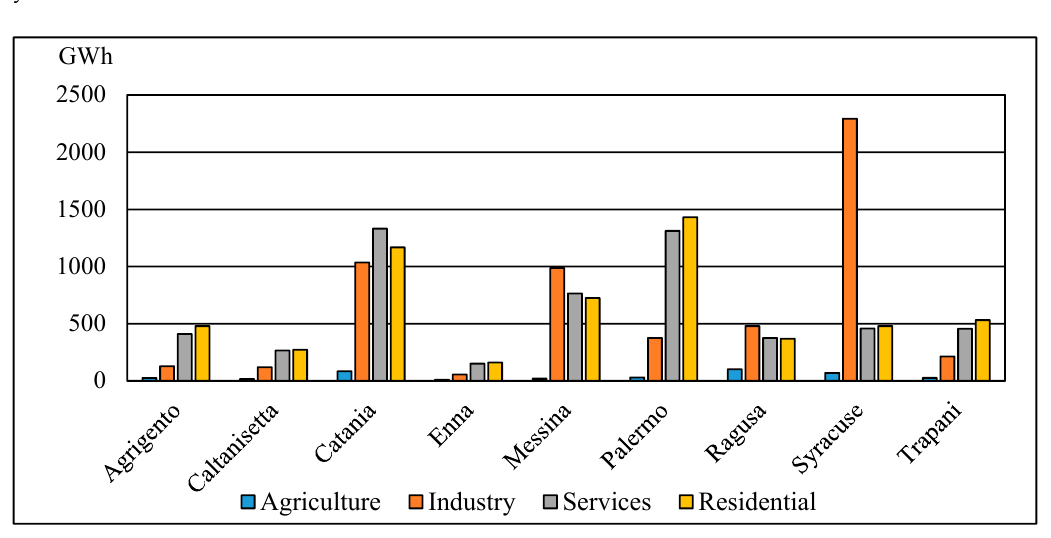
Figure 5. Electrical energy consumes by sectors and provinces in Sicily, during 2015.